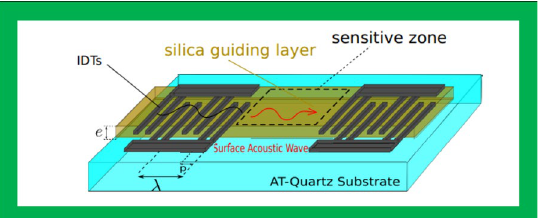
Fig. 10 Structure of a surface acoustic wave based on a delay line built on an AT-cut quartz substrate, produced by